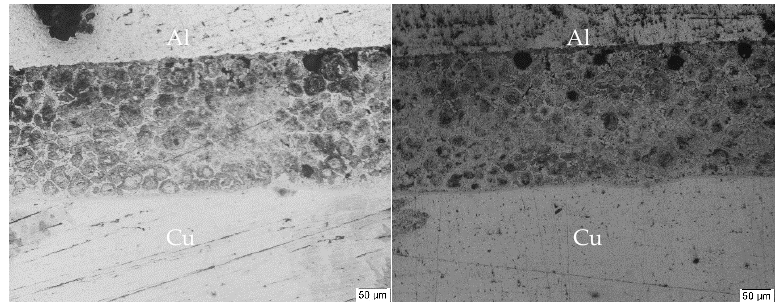
Figure 8. Microstructure of welds with different ultrasonic vibration duration : ( a ) 0 s; ( b ) 2 s; ( c ) 4 s; ( d ) 6 s; ( e ) 9 s.